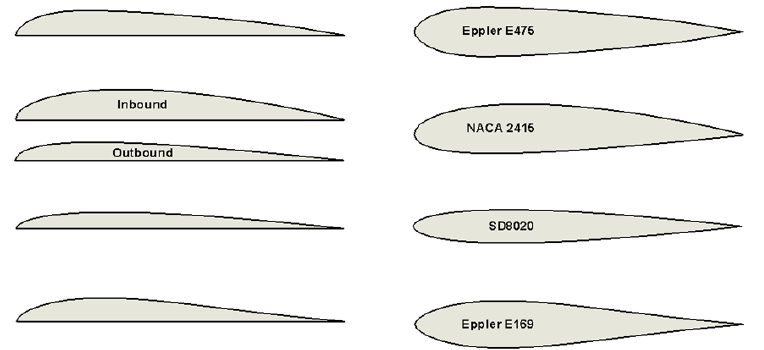
Figure 15. Airfoils samples, originally selected for high velocity ( right ) and their resulting airfoil upon unfolding ( left ).